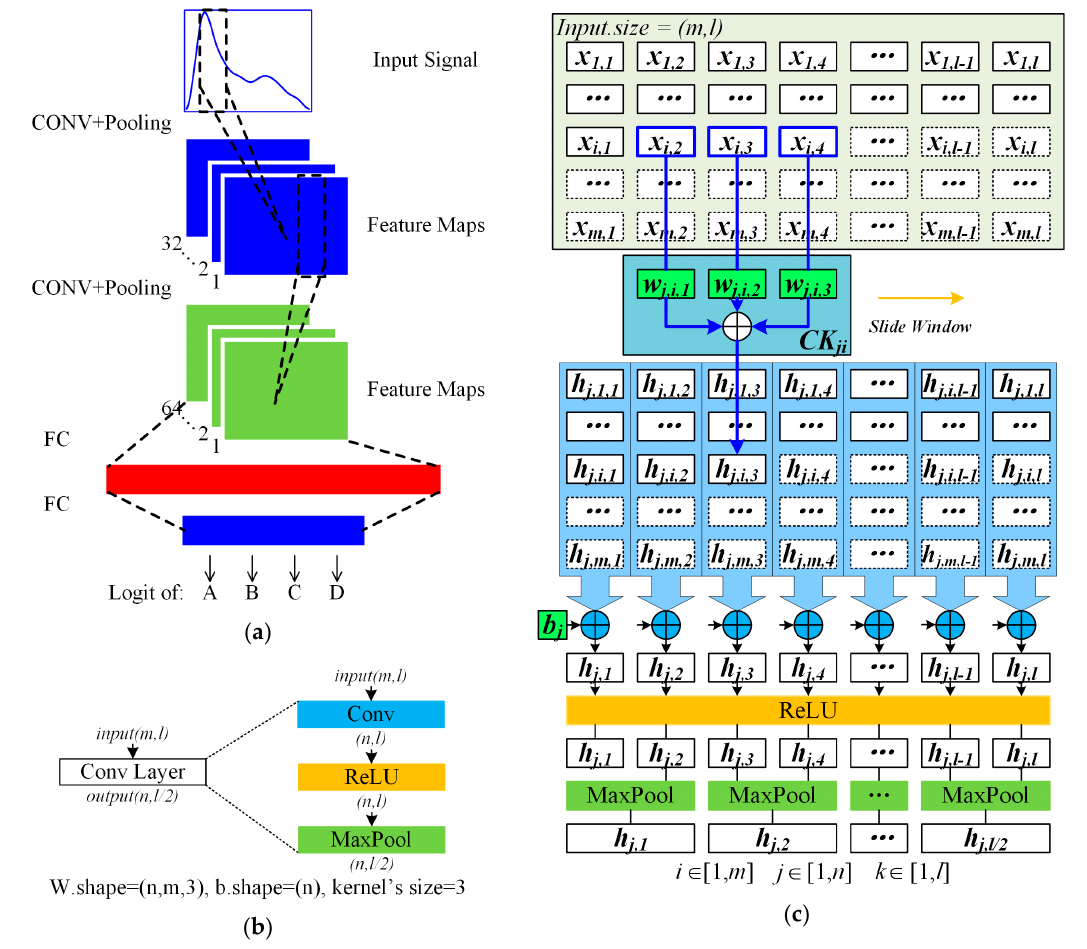
Figure 4. CNN model and convolution (CONV) layer. ( a ) a CNN model includes 2 CONV layers and 2 FC layers; ( b ) 3 operation types of CONV layer; ( c ) complete calculation procedures of convolution layer.